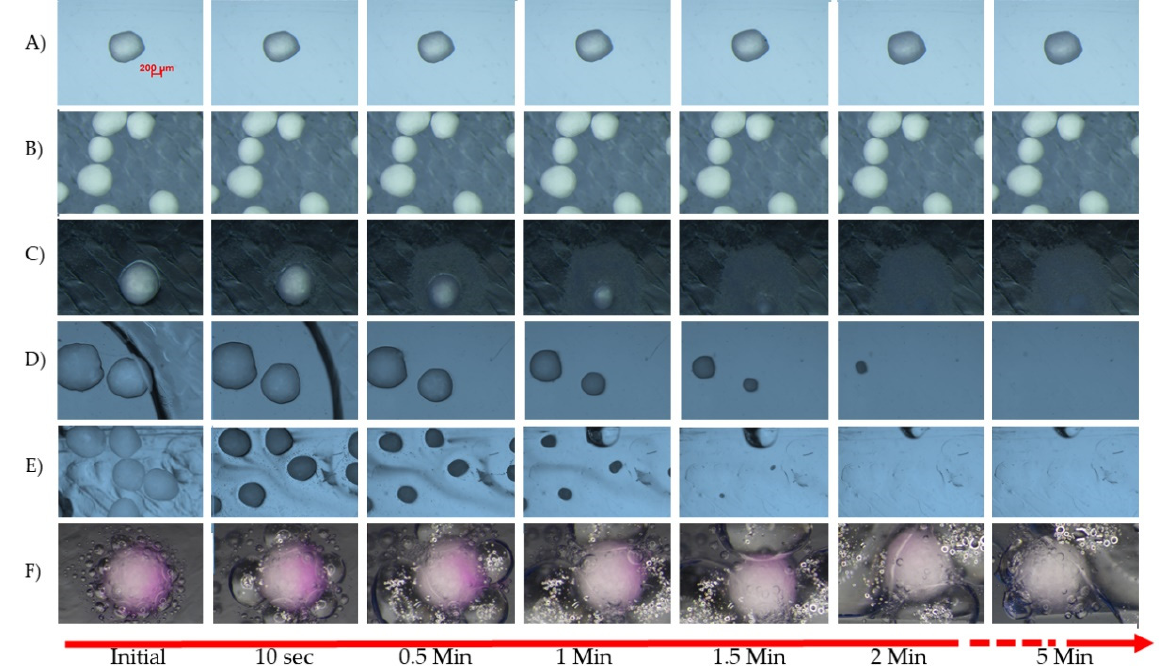
Figure 9. Effect of pH 1.2 HCl dissolution medium on different inert cores. ( A ) MCC spheres: Ethispheres ® (NPPharm Ltd., France); ( B ) DCPA spheres: PharSQ ® Spheres (Chemische Fabrik Budenheim, Budenheim, Germany; ( C ) Sugar core: Suglets ® ; (Colorcon, Bazainville, France); ( D ) Isomalt cores: galenIQ TM 980 (Beneo GmbH, Mannheim, Germany); ( E ) Tartaric acid cores: TAP (IPC Process-Center GmbH, Dresden, Germany) ( F ) Sodium bicarbonate core: (Umang Pharmatech Pvt Ltd., Thane, India) (Latter medium contains Phenolptalein solution R (Ph. Eur. 10) as an indicator).